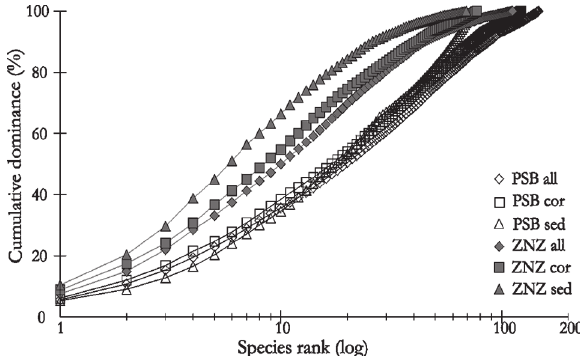
Fig . 4. – k-dominance curves for pooled samples per microhabitat (sediment: sed, cor: coral) and for the combined community in the two microhabitats (all), in the cold-water coral degradation zone at the Porcupine seabight (PsB) and the tropical lagoon on Zanzibar